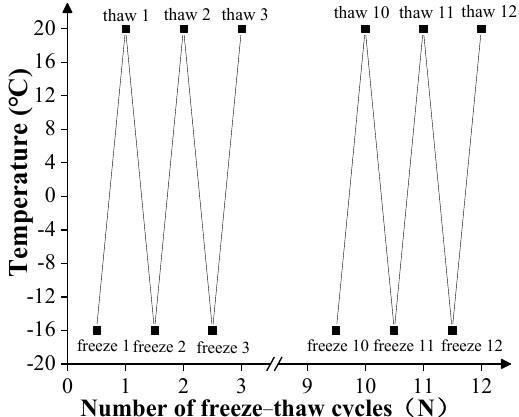
Figure 3. Process of freeze − thaw cycles.